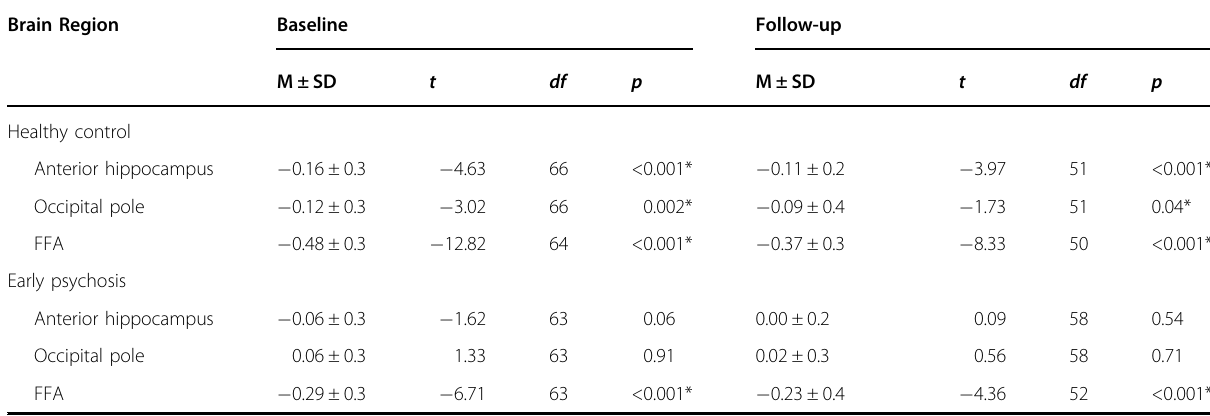
Table 2 Habituation. Brain